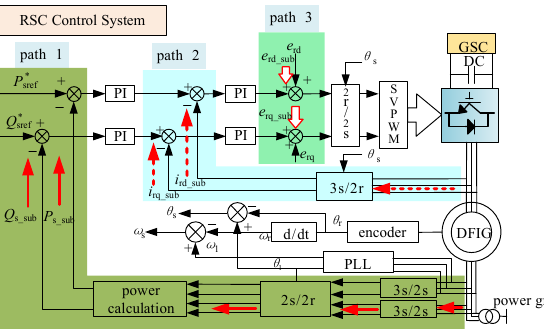
Figure 1. Schematic diagram of SSO propagation in RSC control system.